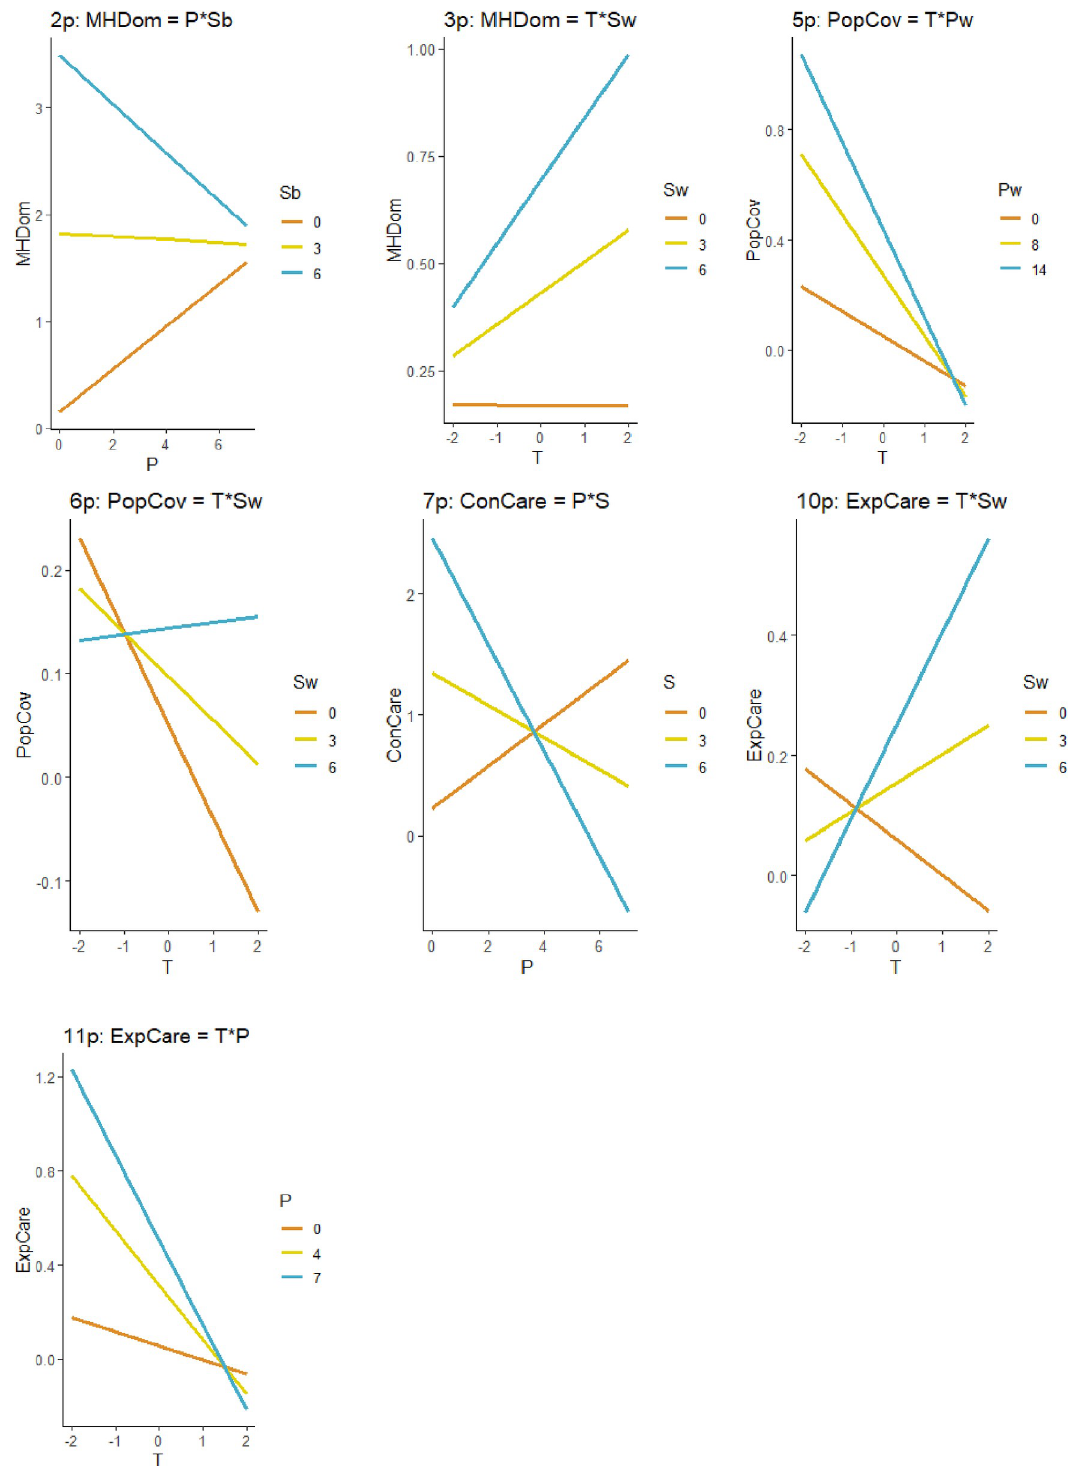
Fig 1. Interactions between predictors in top models. T = Time. S = Staffing (overall). Sb = Staffing (between facilities). Sw = Staffing (within facilities). P = Productivity (overall). Pb = Productivity (between facilities). Pw = Productivity (within facilities).